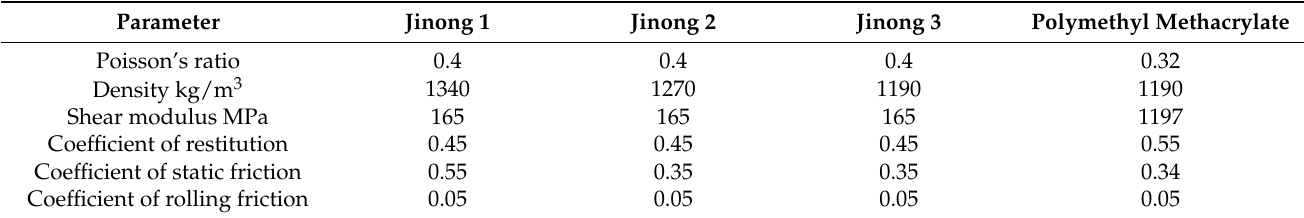
Table 11. Simulation parameters of the piling